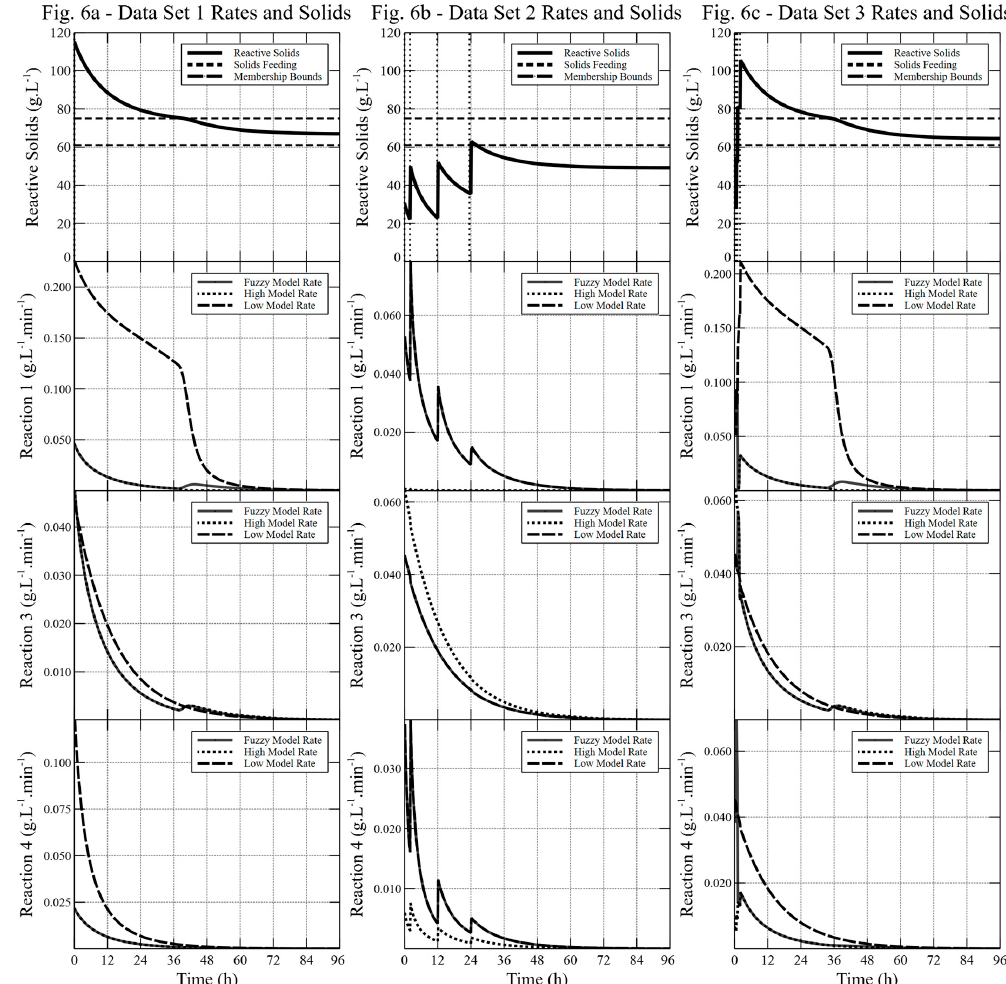
Figure 6. Fuzzy model, high solids model and low solids model reaction rates as a function of solids concentration—( a ) Solids concentration and rates for reactions 1, 3 and 4 for the models in Data Set 1; ( b ) Solids concentration and rates for reactions 1, 3 and 4 for the models in Data Set 2; ( c ) Solids concentration and rates for reactions 1, 3 and 4 for the models in Data Set 3; horizontal lines in the